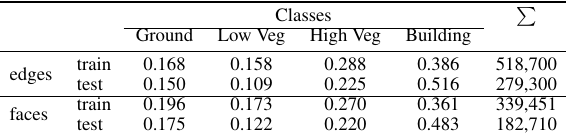
Table 2. Class distribution after data pre-processing. The four class columns are denoted by the ratio of that class. The final column denotes the total amount of primitives.